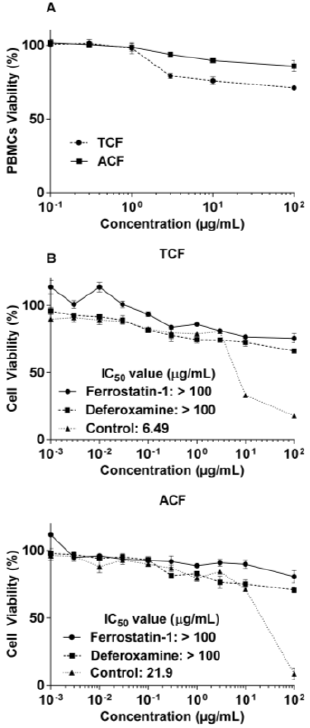
Figure 1. Cytotoxicity of chloroform fractions of T. vulgaris (TCF) and A. lappa (ACF) towards NCI-H929 cells and peripheral blood mononuclear cells (PBMCs) as determined by the resazurin assay. ( A ): Cytotoxicity towards normal PBMCs. ( B ): The ferroptosis inhibitors (ferrostatin-1 and deferoxamine) abrogated cytotoxicity of the extracts, indicating the role of ferroptosis cell death. Control: NCI-H929 cell without ferroptosis inhibitors.